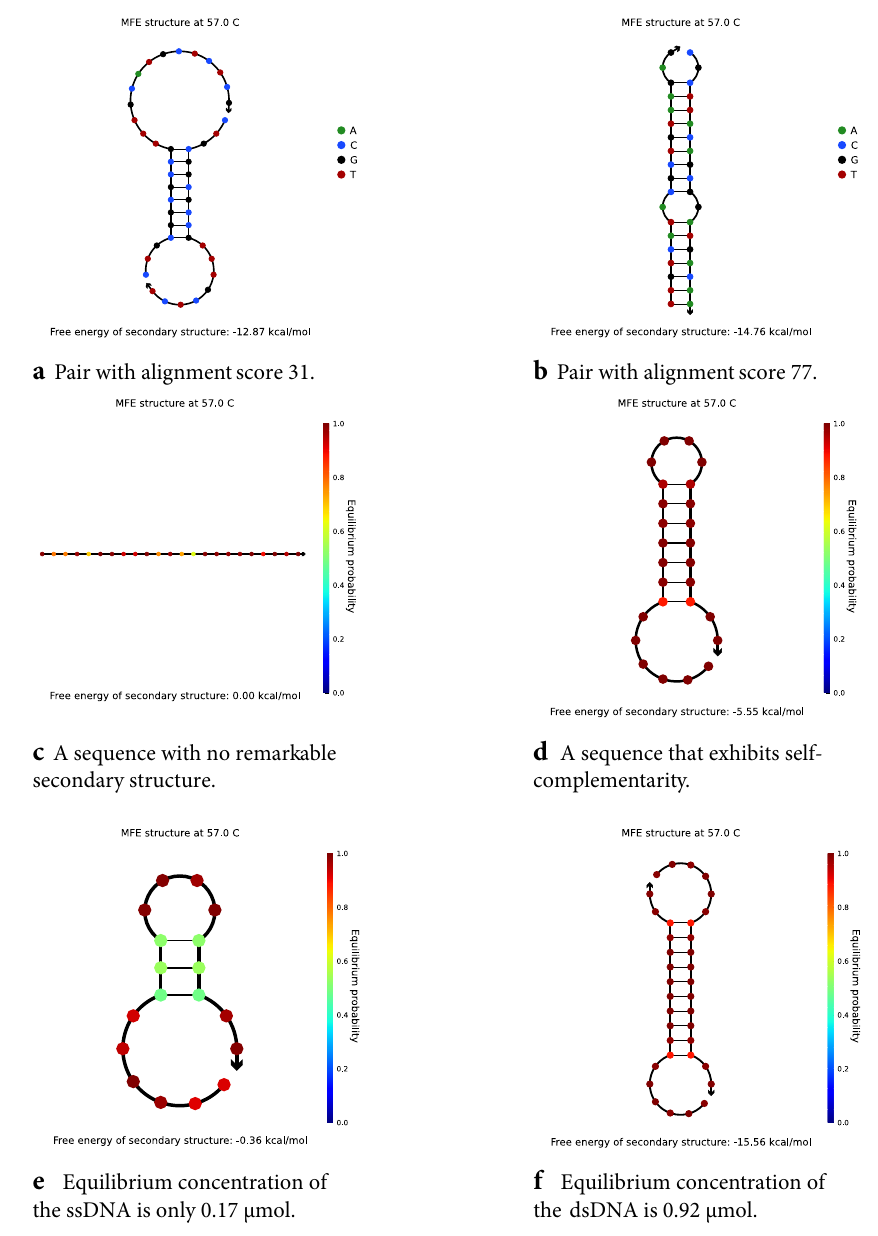
Figure 3. Alignment and thermodynamic properties for various DNA sequences as reported by NUPACK. ( a , b ) Duplex structure predicted by NUPACK (see parasail alignments in Supplementary Information 1). The parasail alignment is not in full agreement with the predicted binding. ( c , d ) For single-stranded DNA, a low MFE indicates a high probability that the molecule develops self-complementarity or knots. ( c ) A sequence that is expected to be stable ( AGT ACA AGT AGG ACA GGA AGATA ). ( d ) A sequence that is expected to be more problematic in hybridisation reactions